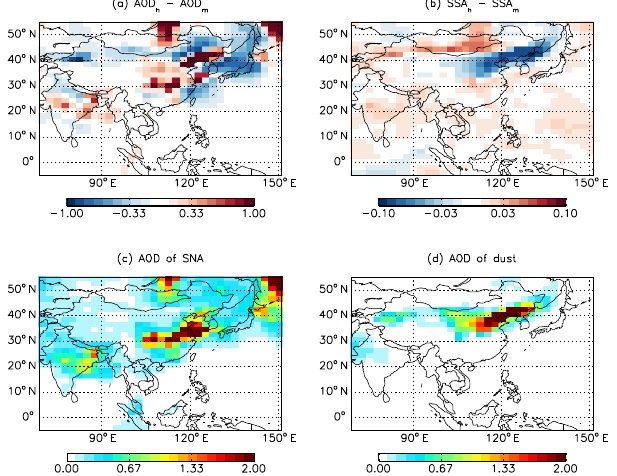
Figure 7. Differences at 12:00LST on 21 June 2009 between hourly and monthly (a) AOD and (b) SSA. AOD of (c) sulfate–nitrate– ammonium (SNA) aerosols and (d) soil dust aerosols at 12:00LST.